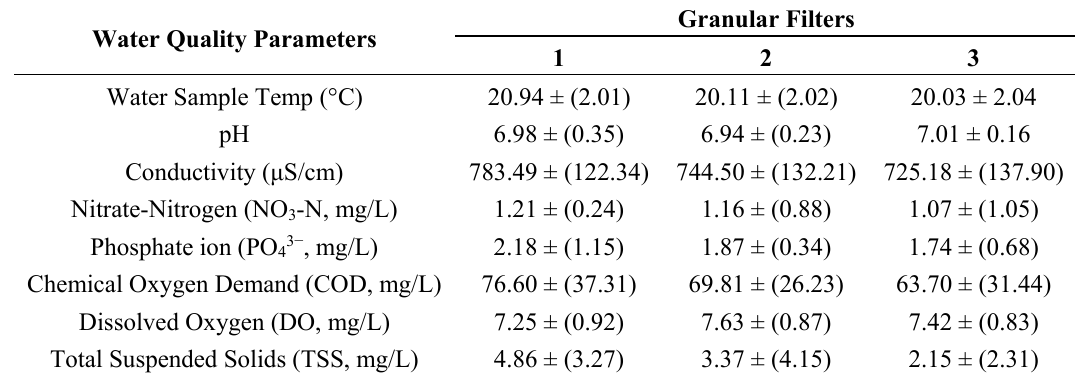
Table 3. Overall measured outflow—Mean (and Standard Deviation) of various effluent characteristics for each pilot granular filter rig, sample number n = 80 and period of analysis (May 2012–October